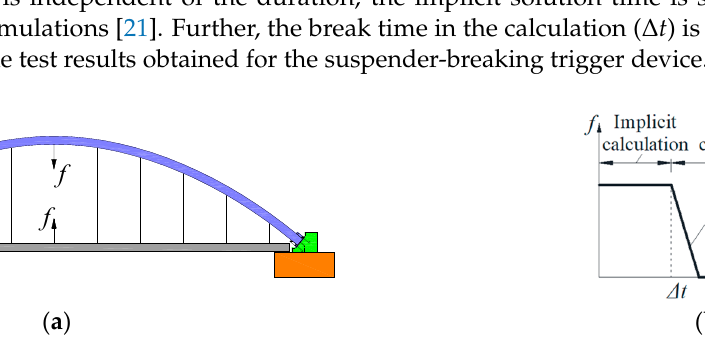
Figure 11. Schematic representation of the FE simulations of the suspender fracture: ( a ) dynamic simulation of the suspender break; ( b ) the time ‐ load curve.